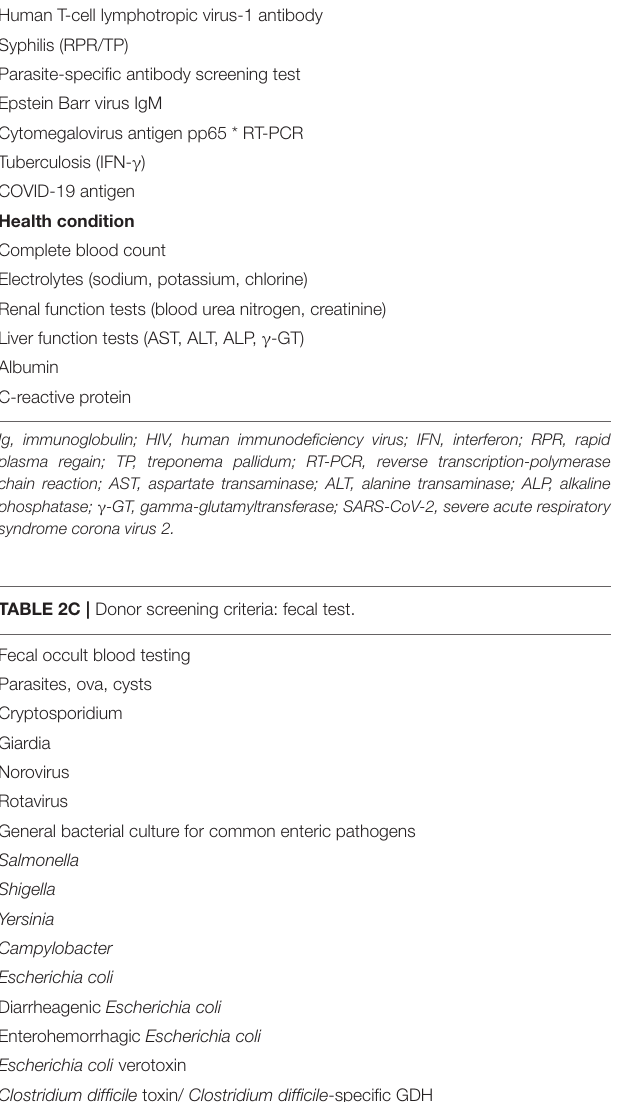
TABLE 2B | Donor screening criteria: blood test. Infections